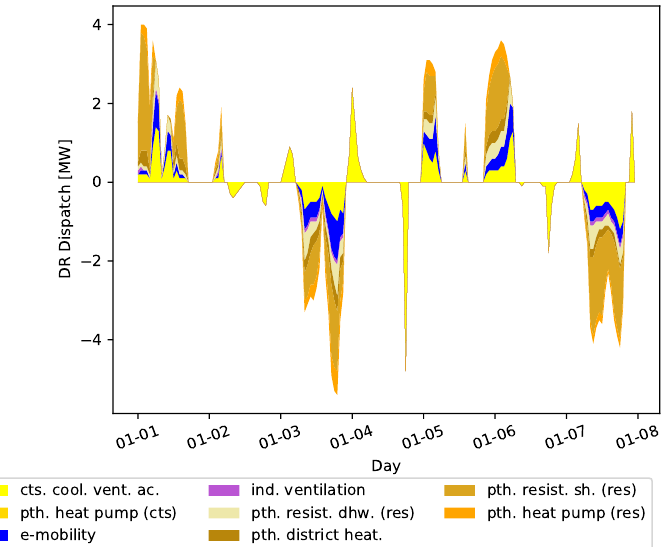
Figure 12. Dispatch of DR technologies at a grid node close to the city of Dortmund in the first week of the year for the case without investment costs